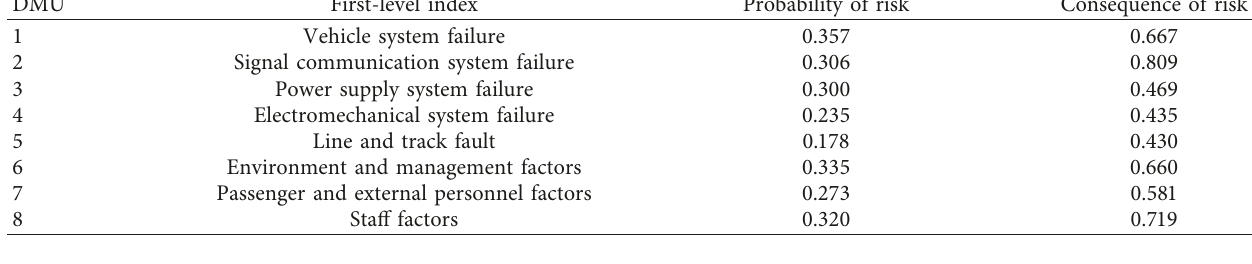
Table 3: Risk index data of each